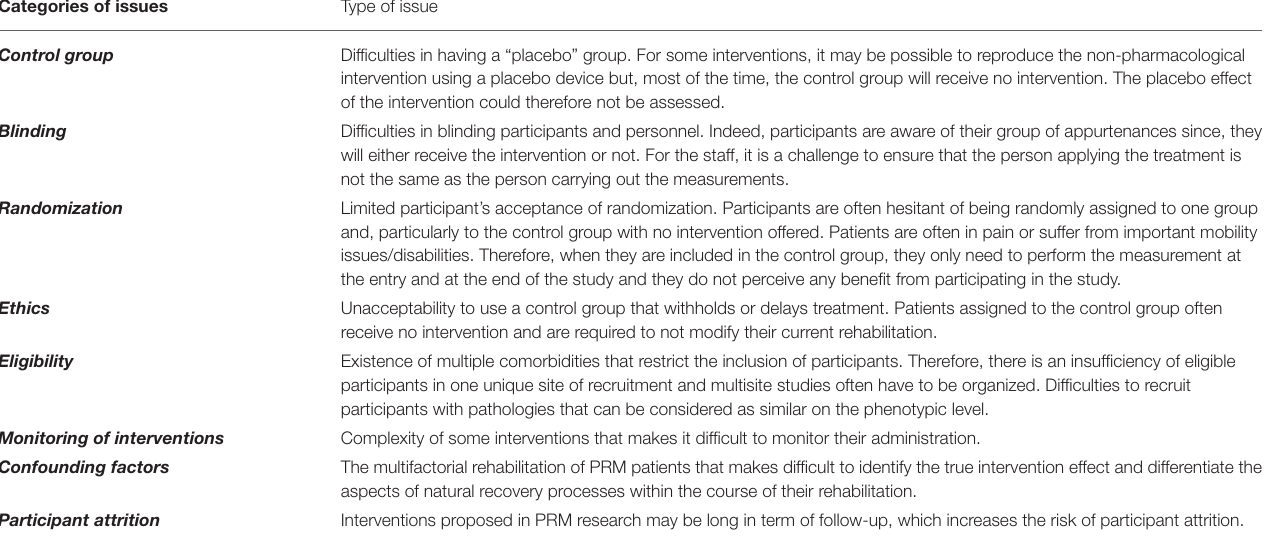
TABLE 3 | Methodological problems in rehabilitation research